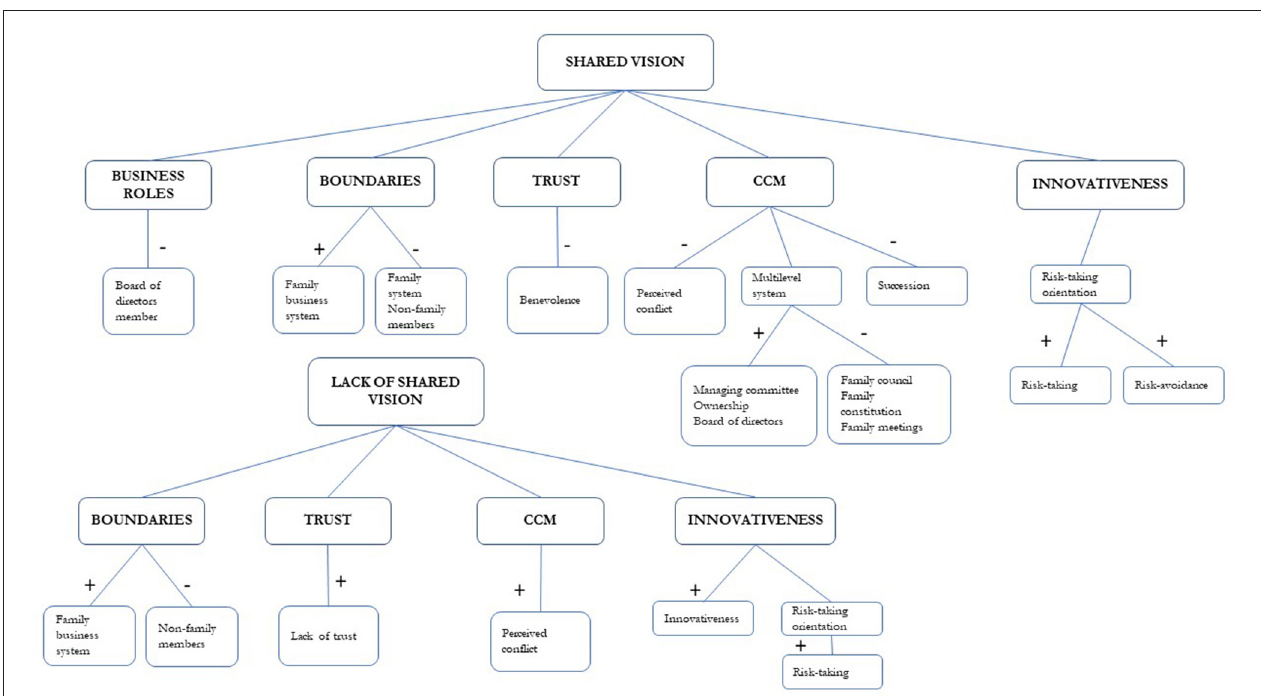
FIGURE 3 | Structure of significant associative relationships of shared vision dimension (